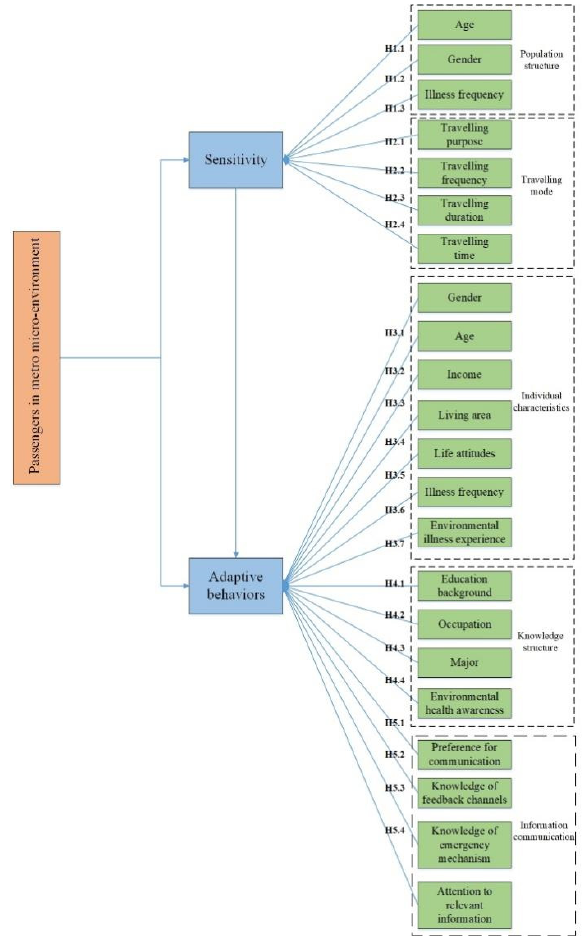
Figure 1. Theoretical model and hypotheses. (Note: H stands for hypothesis.)